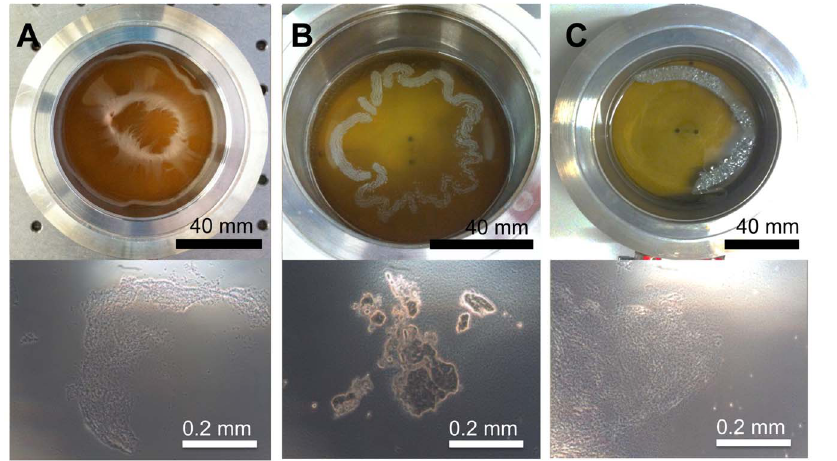
Figure 3. Biofilm formation at the water-air interface. Macroscopic (top) and microscopic images (bottom) of biofilms formed at the water-air interface after 72 h of P. fluorescens (A), E. coli (B) and B. subtilis (C).